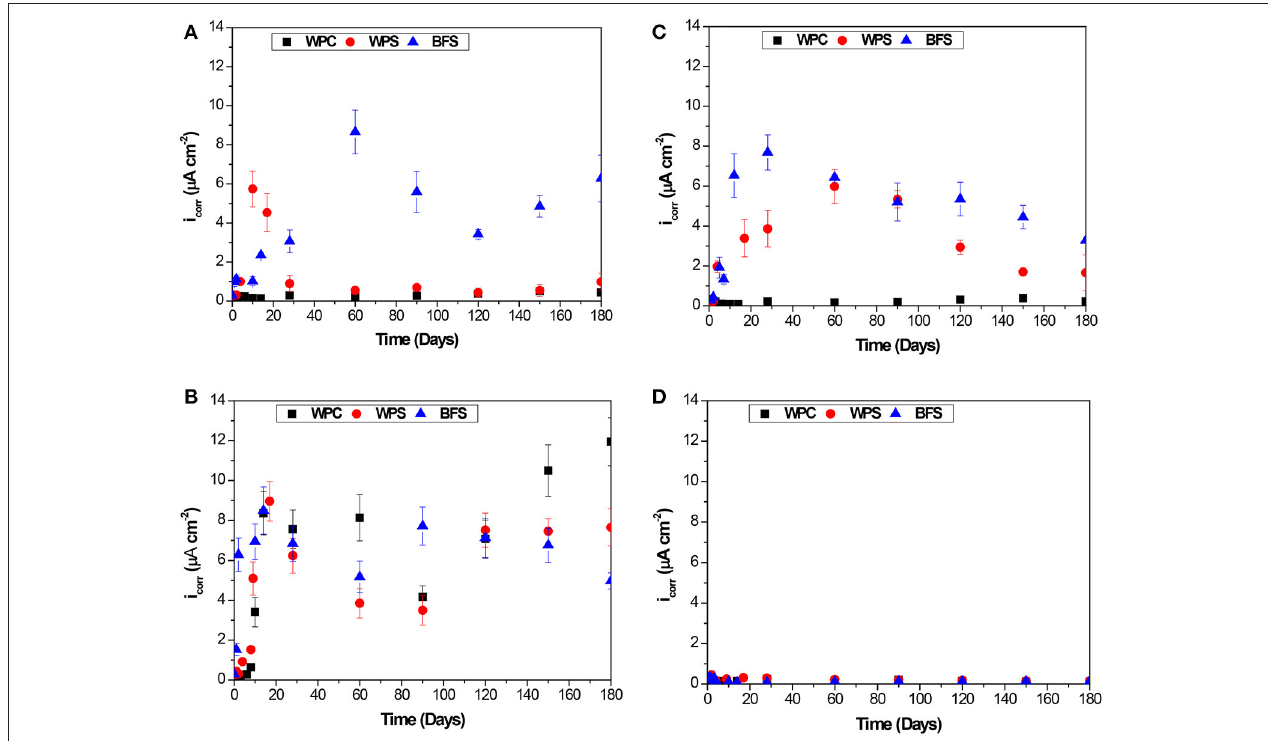
FIGURE 6 | Evolution of the corrosion current density values as a function of time, for steel embedded in BFS, WPS and WPC mortars immersed in (A) alkaline solution, (B) alkaline chloride-rich solution, (C) water, and (D) exposed to standard laboratory conditions, after 7 days of curing under sealed conditions.